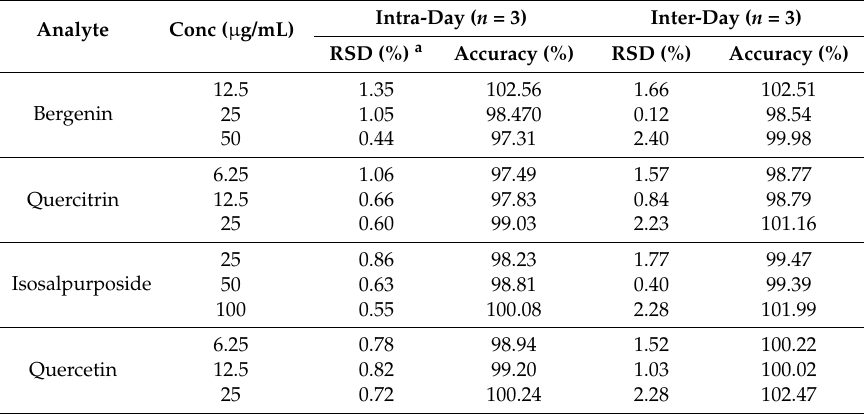
Table 3. Analytical results of intra-day and inter-day precision and accuracy.